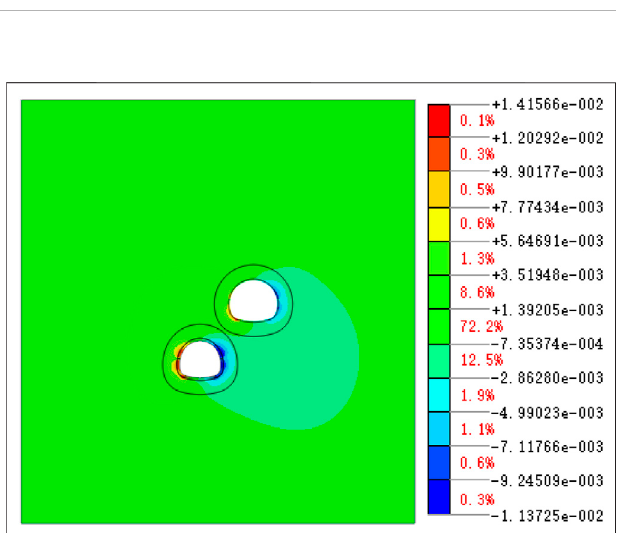
FIGURE 7 | Vertical displacement after excavation of the upper tunnel (unit: m). FIGURE8| Horizontaldisplacementafterexcavationoftheuppertunnel